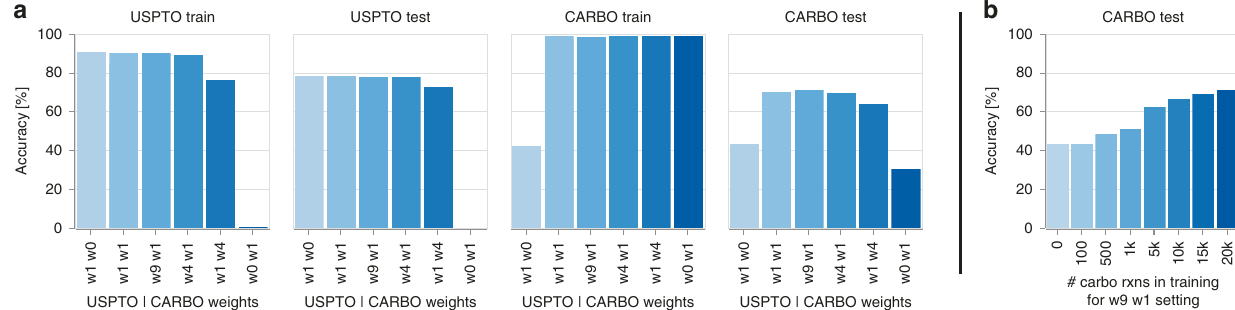
Fig. 2 Multitask scenario results. a Top-1 accuracy of models trained with different weights on the USPTO and CARBO data set (the fi rst number corresponds to the weight on the USPTO data set and the second to the weight on the CARBO data set). b Top-1 accuracy for a model trained in the weight 9 weight 1 setting, where the number of reactions in the CARBO data set was reduced. Source data are provided as a Source Data fi